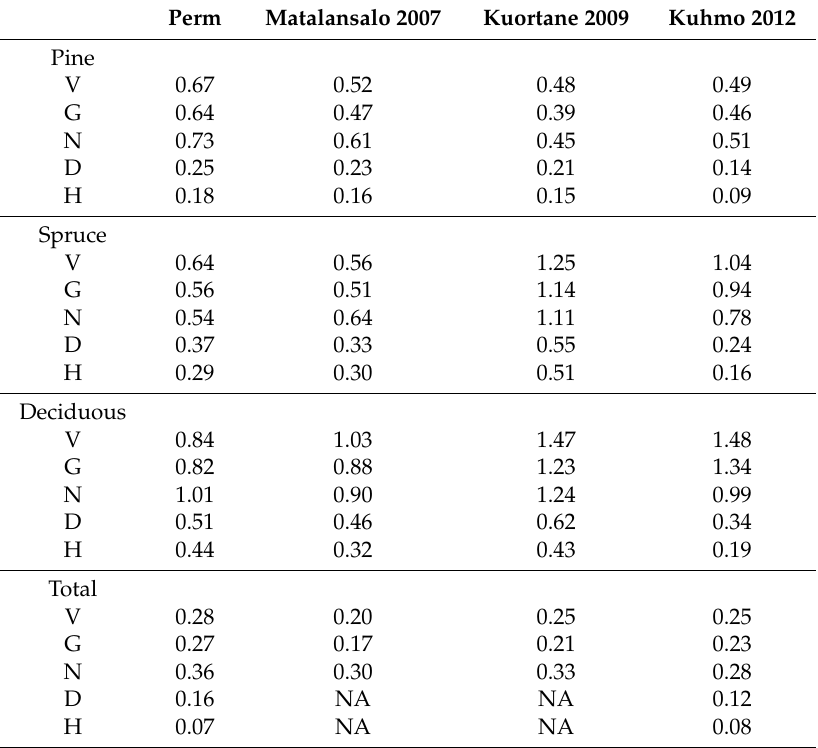
Table 3. Plot level root mean square errors (RMSE) values relative to the mean in the Perm and Finnish studies. Perm Matalansalo 2007 Kuortane 2009 Kuhmo